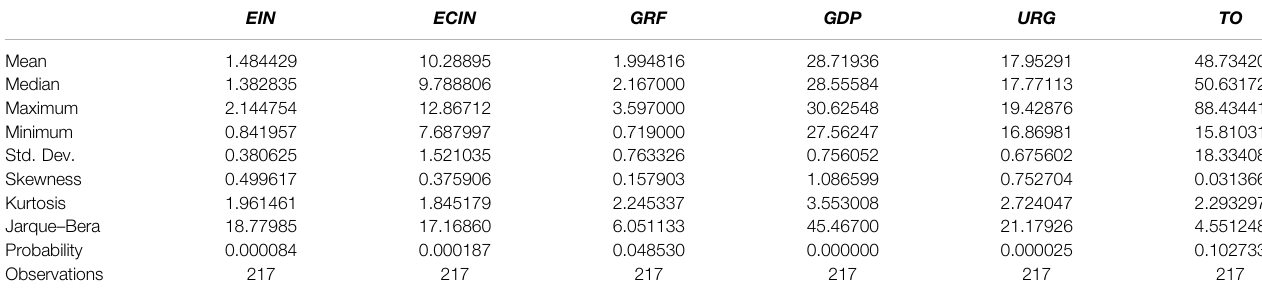
TABLE 2 | Descriptive statistics and normality check.